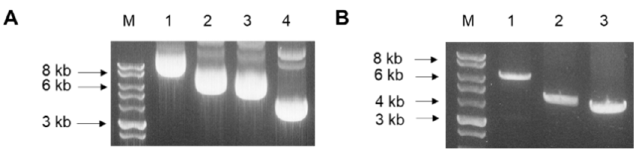
Figure 2. Successful cloning of S protein inserts. Codon-optimized genes were successful cloned into pFastBac vector ( A ). Vectors containing each insert were transformed into DH10Bac competent cells and bacmids were analyzed via colony PCR ( B ). Lane identifications for both panels are as follows: M, marker; 1, S full; 2, S1; 3, S2; 4, pFastBac vector.